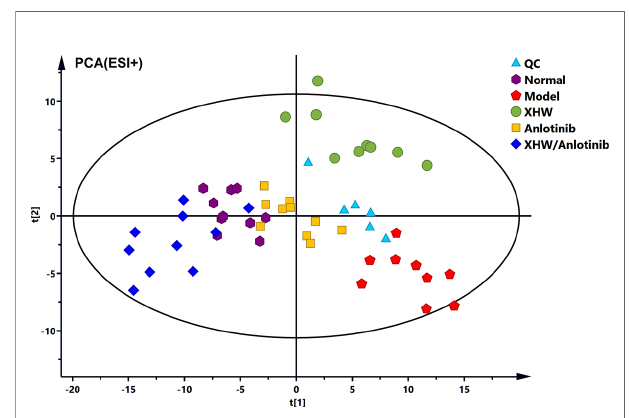
FIGURE 3 | (PCA score plots of the combination of anlotinib with XHW against lung cancer in